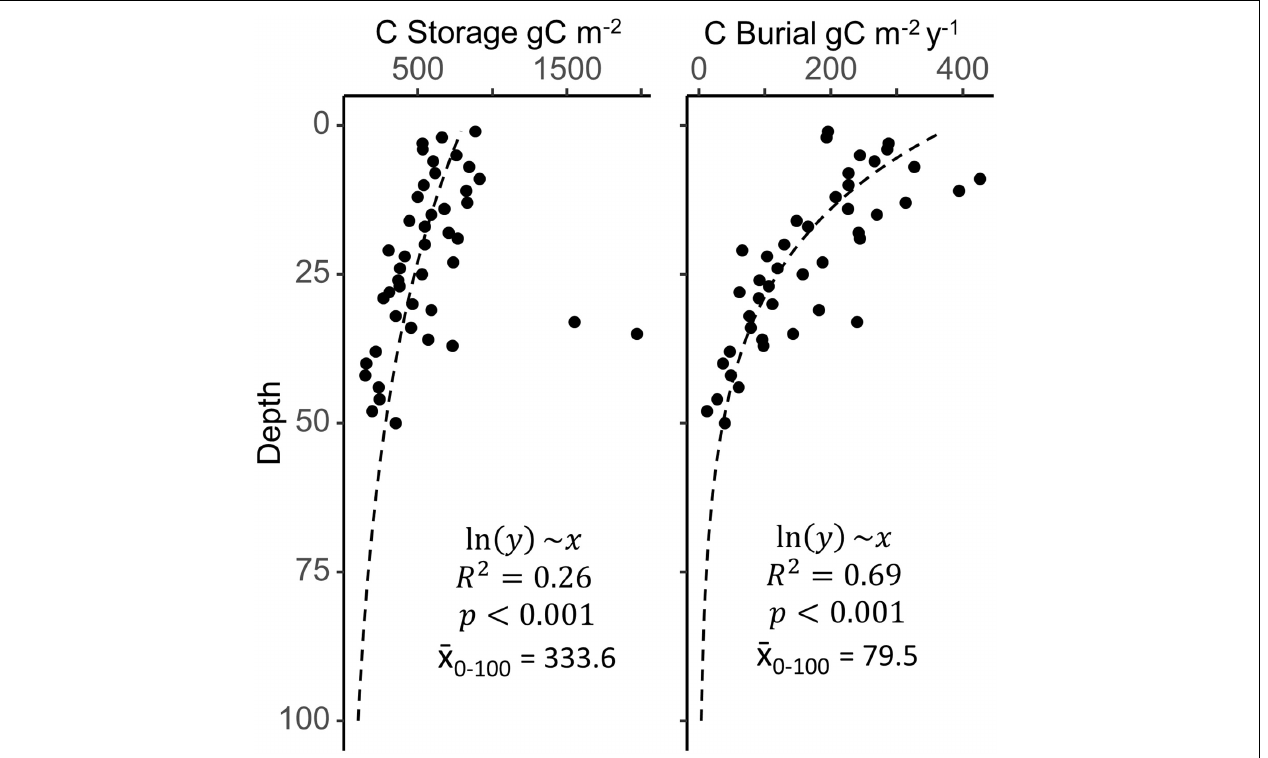
FIGURE 6 | Mean depth profiles for carbon (C) storage and burial across all sites, with the deepest layers approximated by extrapolation of a log transformed linear model (¯x 0 − 100 is the mean of modeled values from 0 to 100 cm of depth). Filled circles are combined mangrove soil data from nine San Juan Bay Estuary cores. Site specific depth profiles (not shown) varied greatly and may not necessarily follow the estuary-wide